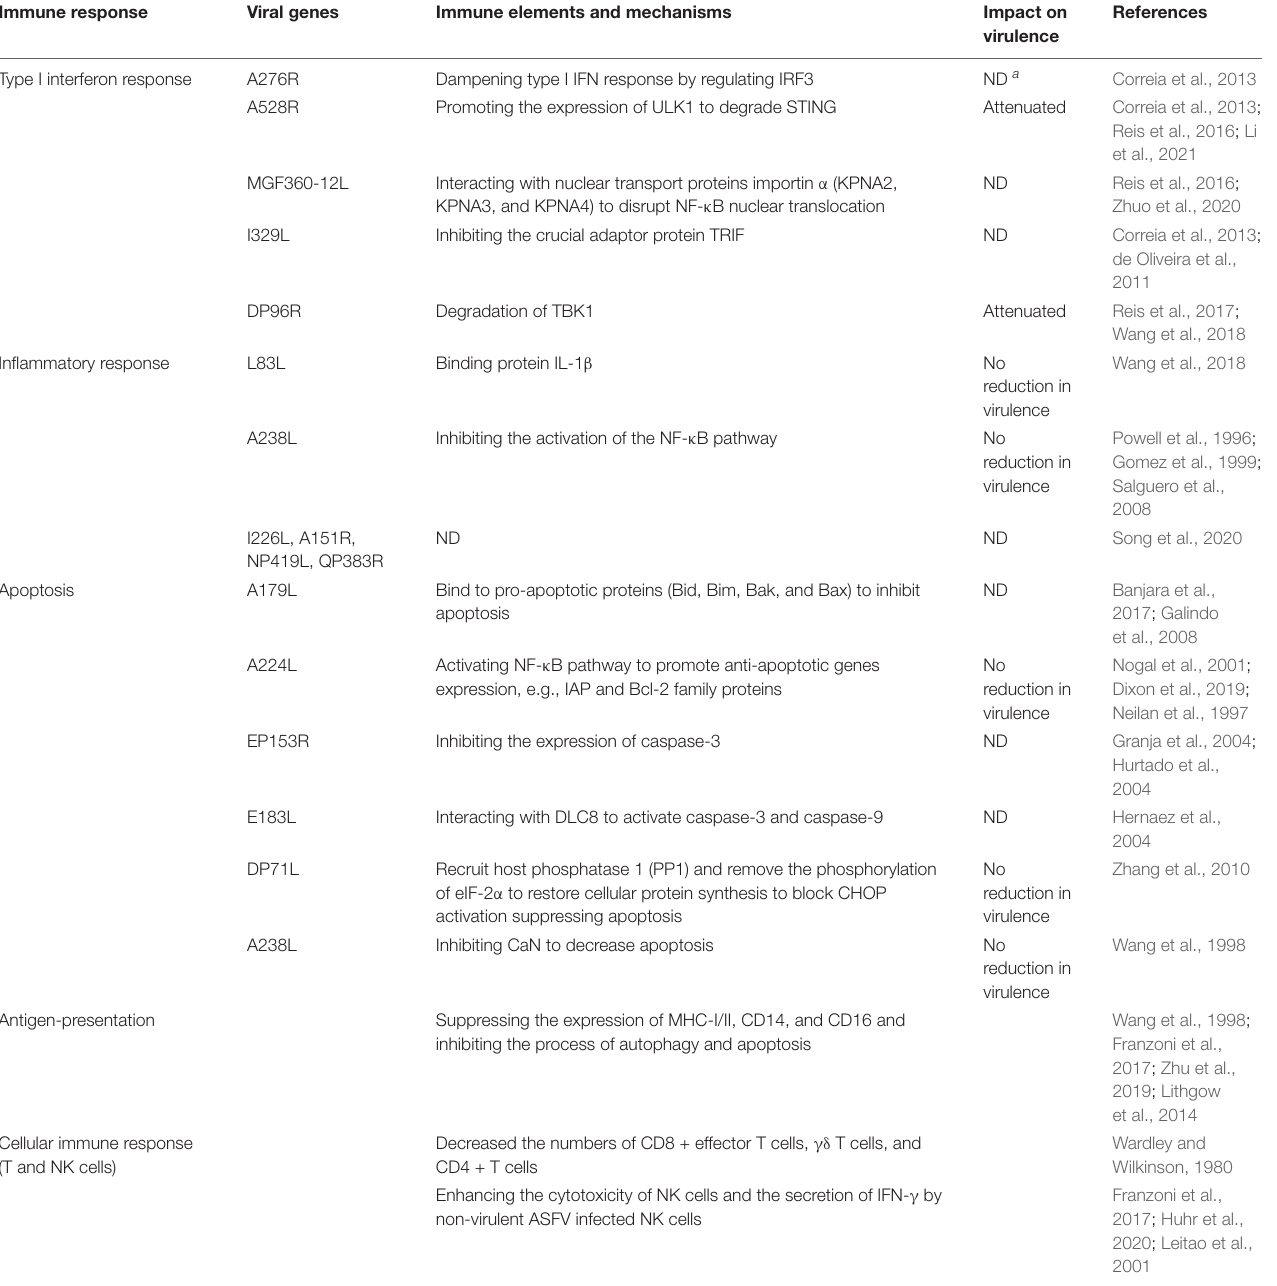
TABLE 1 | Host immune responses known to be regulated by African swine fever virus